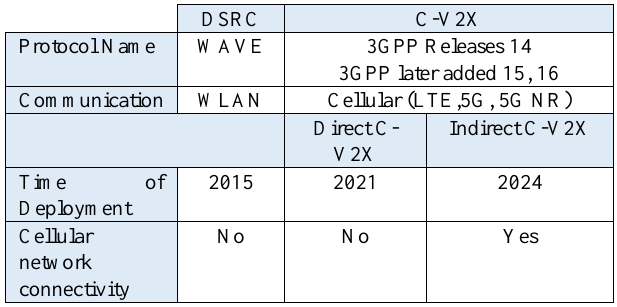
Table 1. The difference between DSRC and C-V2X systems However, there are some similarities between DSRC and C- V2X: Both of them use the same message sets (SAE J2735 and J2945).(IWave Systems, 2020) . Also, they use digital signatures to ensure security and trust in message providers.